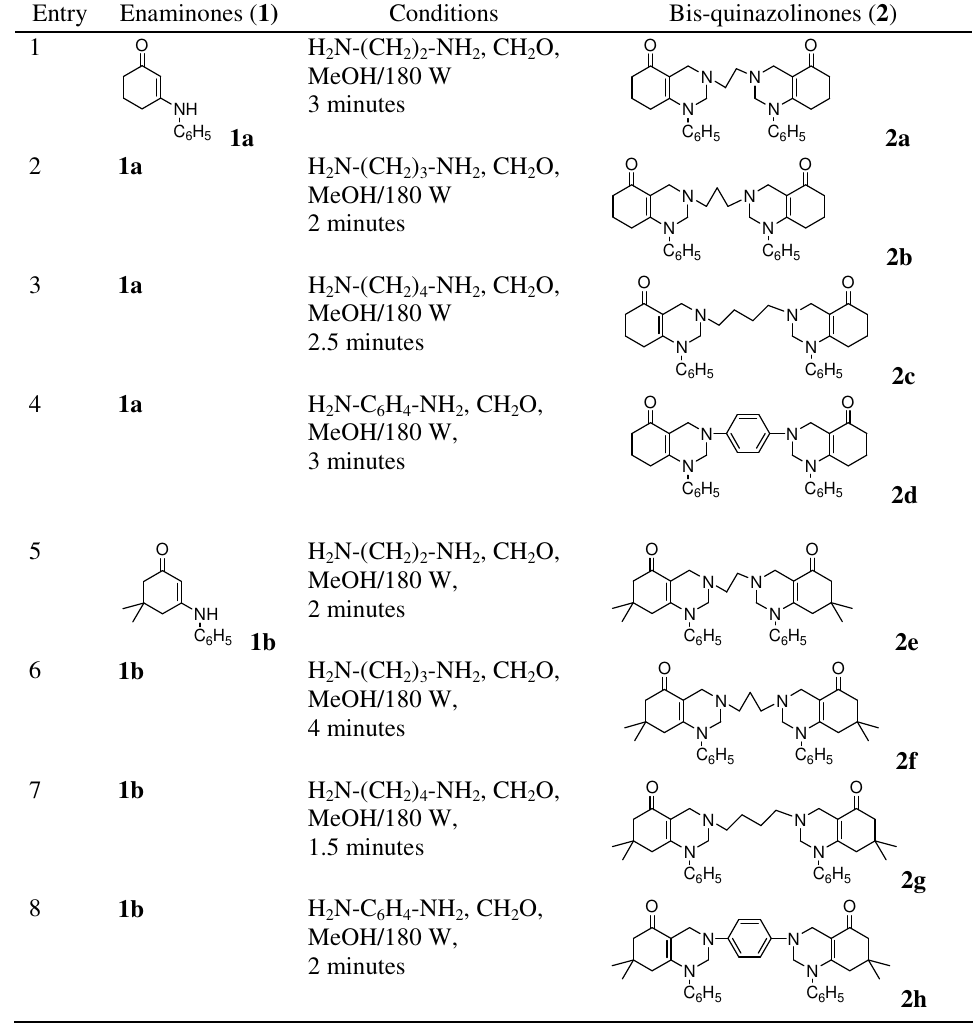
Table 2. Comparison of microwave irradiation and thermal condition results